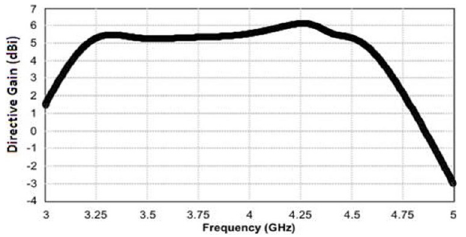
Figure 12. Variation of simulated gain of stacked antenna geometry with air gap and shorting